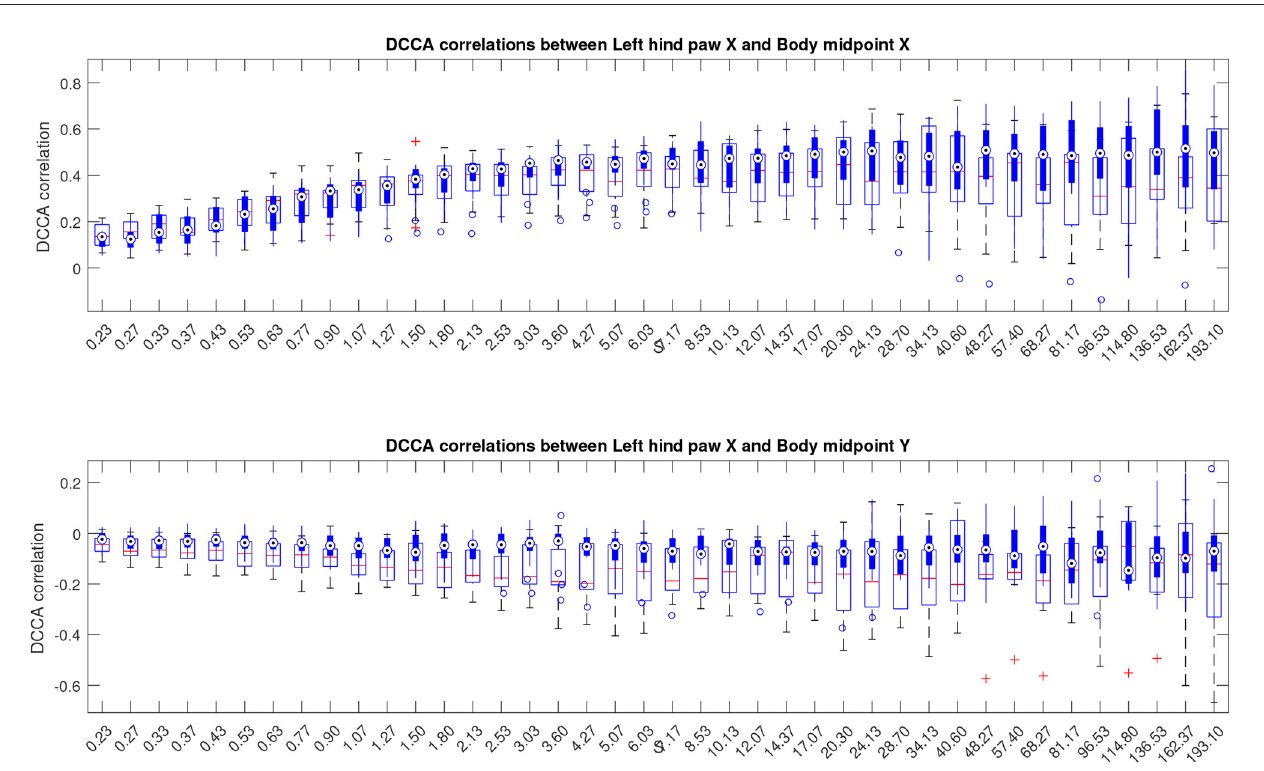
FIGURE7 Boxplots indicating partial cross-correlations of the left hind paw along the X-axis relative to the animal body midpoint as a function of scale S obtained by detrended partial cross-correlation analysis (DPCCA). The upper panel shows correlations with midbody movements along the same X-axis, representing specific correlations, while the lower panel shows correlations with midbody movements along the orthogonal Y-axis that one could expect to be unrelated, at least to a certain approximation, and thus indicating the level of unspecific correlations. More similar figures for other body parts are presented in the Supplementary material. Results for animals with Alzheimer’s disease are provided by filled boxes and blue circles for outliers; results for wild type animals (control group) are provided with open boxes and red plus signs for